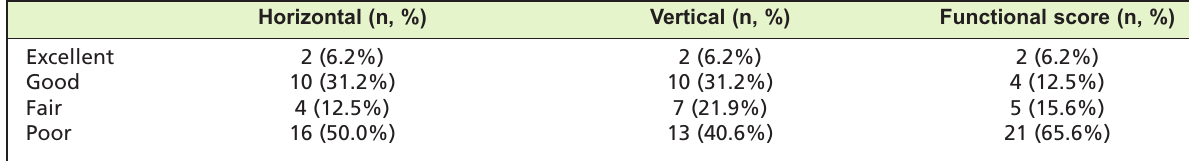
Clinical and functional outcome in terms of quality of scar and Ponseti Laaveg score Table II: